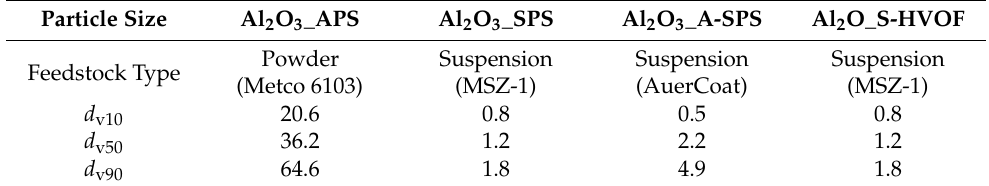
Table 1. Particle size distribution of Al 2 O 3 powders used for deposition of the coatings; d v —particle size by volume [ µ m]; APS—atmospheric plasma spraying, SPS—suspension plasma spraying with radial injection, A-SPS—suspension plasma spraying with axial injection. Particle Size Al 2 O 3 _APS Al 2 O 3 _SPS Al 2 O 3 _A-SPS Al 2 O_S-HVOF Feedstock Type